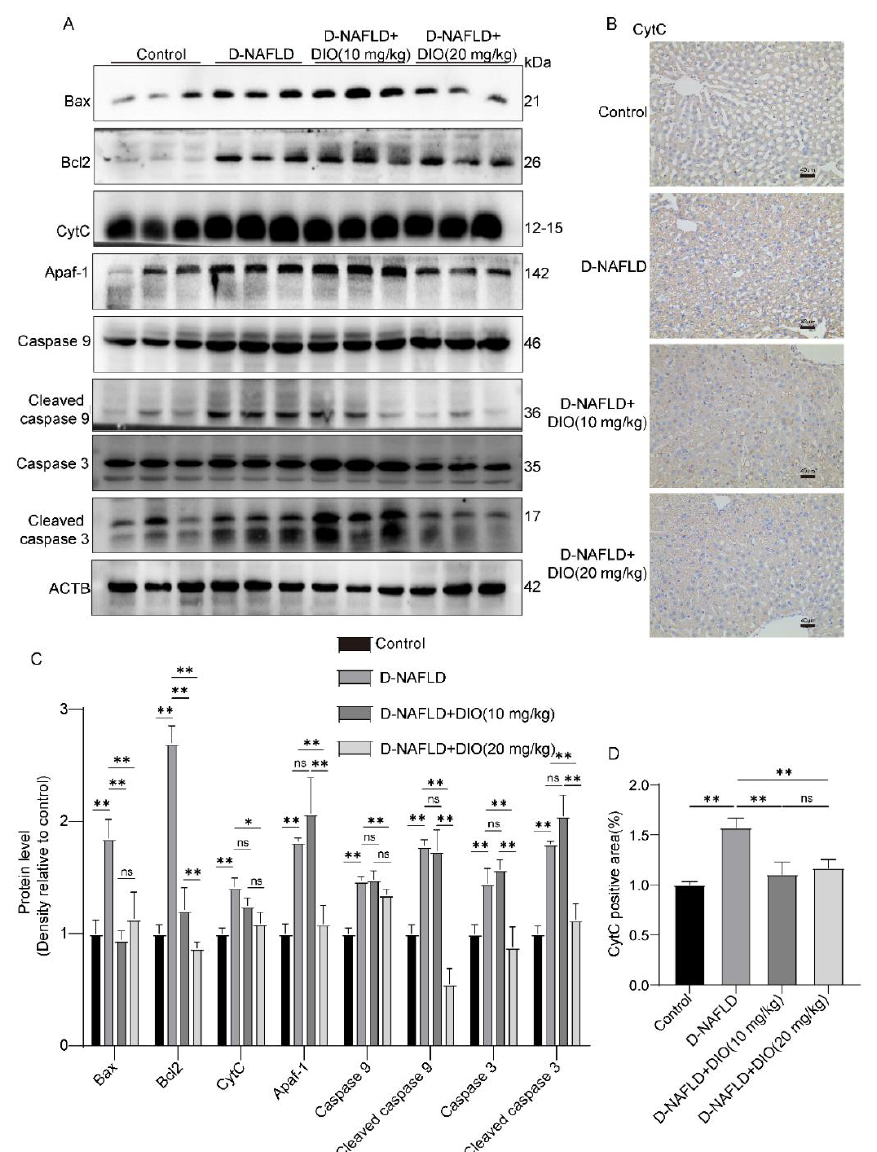
Figure 7. DIO ameliorated mitochondrial apoptosis in the liver of D-NAFLD rats. ( A ) Western blot images of Bax, Bcl2, CytC, Apaf-1, caspase 9, cleaved caspase 9, caspase 3, cleaved caspase 3, and ACTB. ( B ) The images of CytC immunohistochemistry, ×100, scale bars = 40 µm. ( C ) Relative protein expressions of Bax, Bcl2, CytC, Apaf-1, caspase 9, cleaved caspase 9, caspase 3, and cleaved caspase 3. ( D ) CytC positive area in immunohistochemistry. n = 3 and the data were presented as mean ± SD. ns indicates no significance, * and ** indicate significant difference and highly significant difference, respectively.